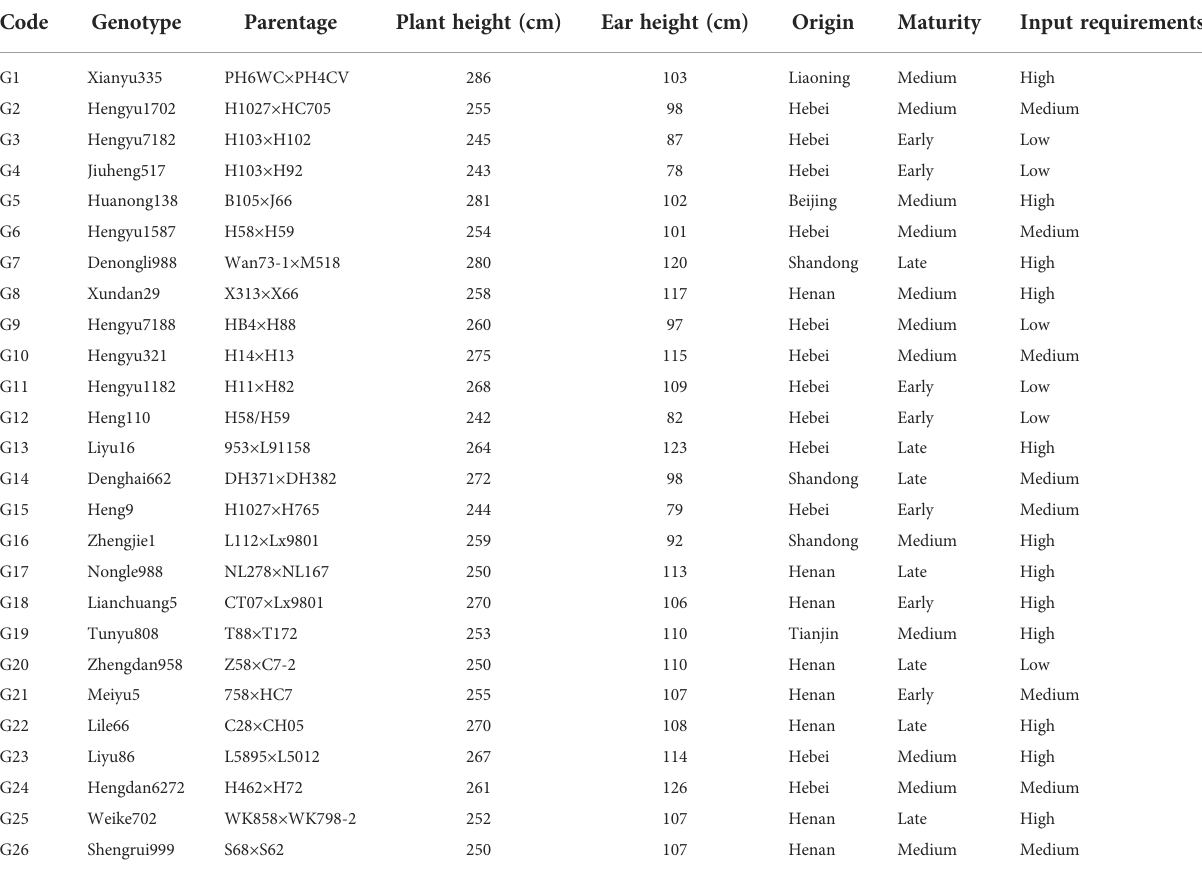
TABLE 1 Basic information of the 26 tested maize